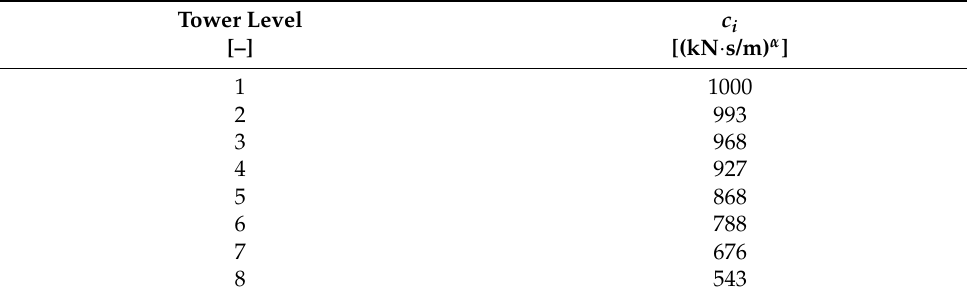
Table 3. Viscous damping coefficients ( α = 1.0).